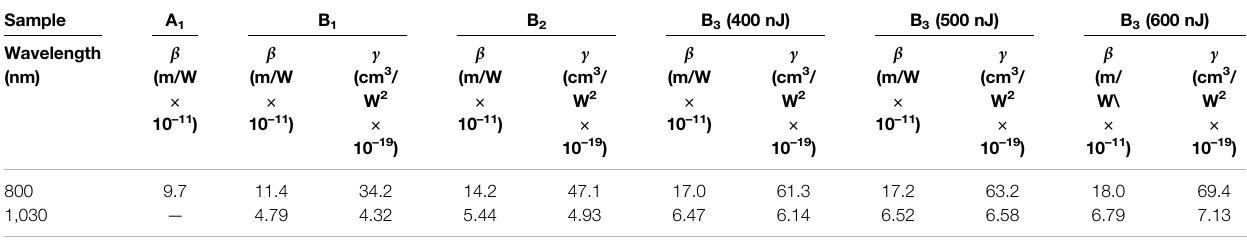
TABLE 1 | Nonlinear absorption parameters of the A and B thin fi lms under different excitation conditions. Sample